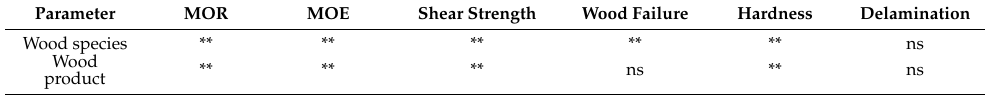
Table 5. Summary of the analysis of variance of mechanical properties. Parameter